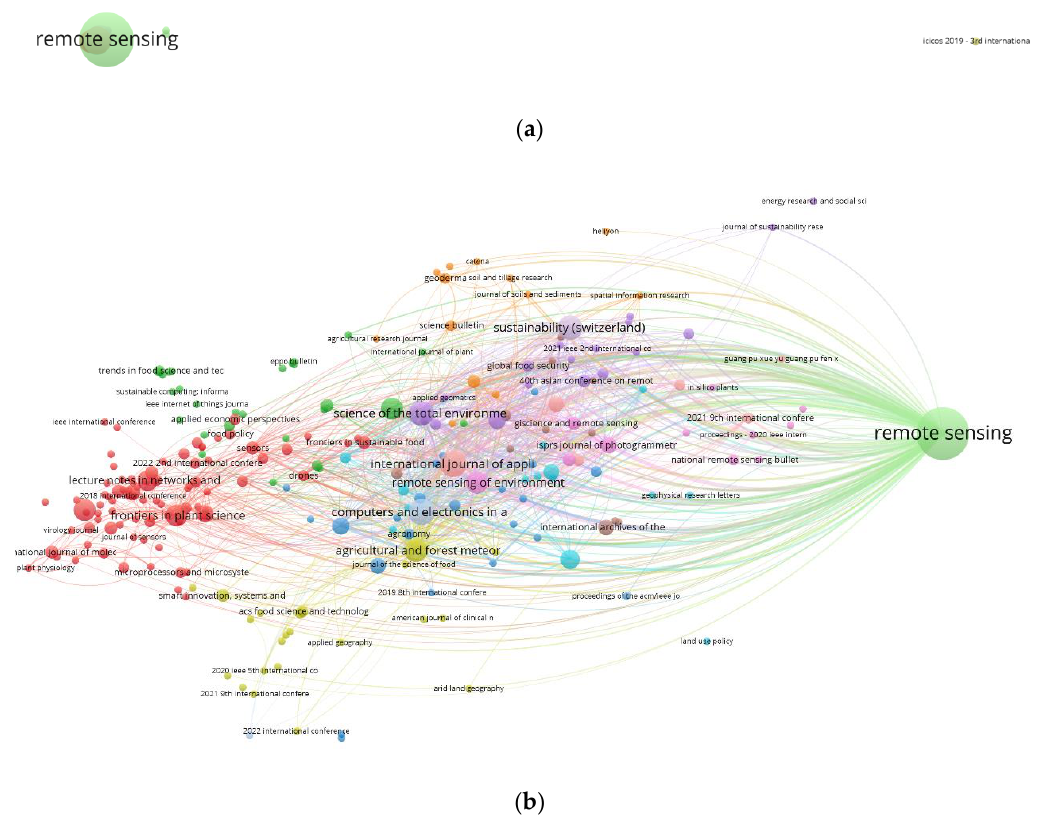
Figure 5. Network visualization map for bibliographic data (bibliographic coupling links and sources as items), considering full counting and 1 as the minimum number of occurrences of a source. ( a ) Full network; ( b ) network around some of the items with the highest documents. Table 5. Top 20 sources with the highest total link strength for bibliographic data, considering full counting and 1 as the minimum number of occurrences of a source.